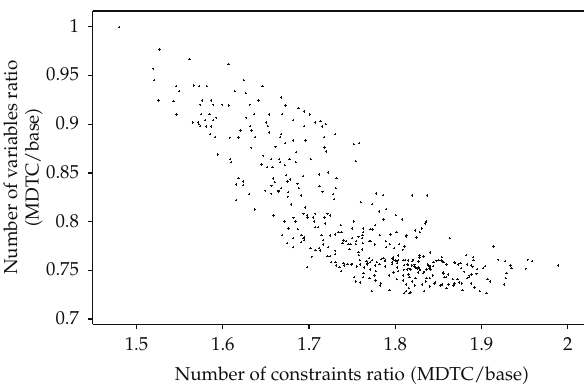
Figure 12: MDTC and base formulation relative size comparison.